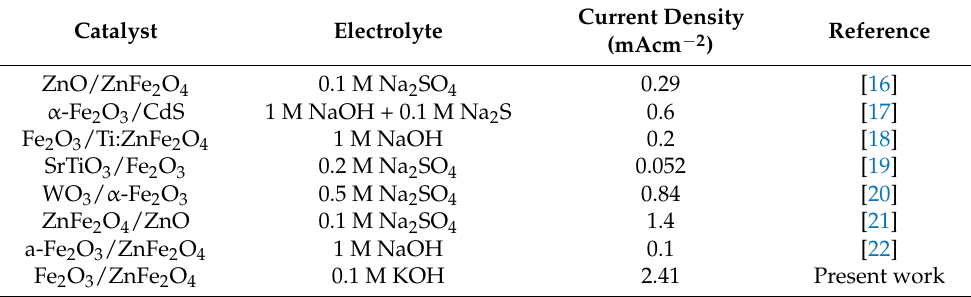
Figure 8. ( a ) Voltammetry analysis of ZnFe 2 O 4 (Z), Fe 2 O 3 (F), and ZnFe 2 O 4 -Fe 2 O 3 (ZF) nanostructures under light ON/OFF states in 0.1 M KOH electrolyte, ( b – d ) chronoamperometry plots recorded at 0.3, 0.5, and 0.7 V in KOH electrolyte. Table 3. Comparison of photoanode performance with reported literature.